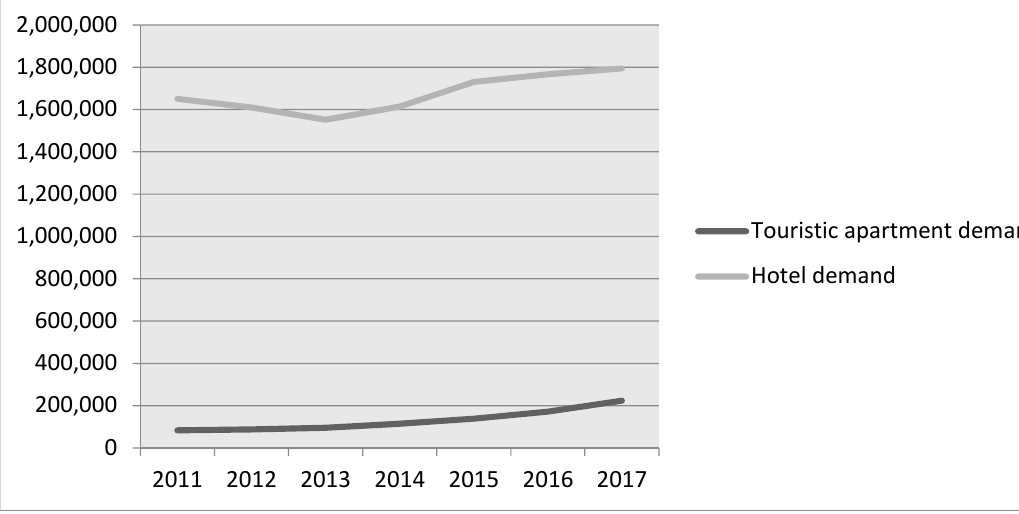
Figure 5. Evolution of Uber and Cabify drivers in Spain. Source: [26]. Figure 6. Accommodation options per district in Valencia. Source: [27]. This shift towards digital platforms has already had an impact on the geography of conflicts in cities like Valencia. Figures 7 and 8 show the main results of the carried out research on conflicts